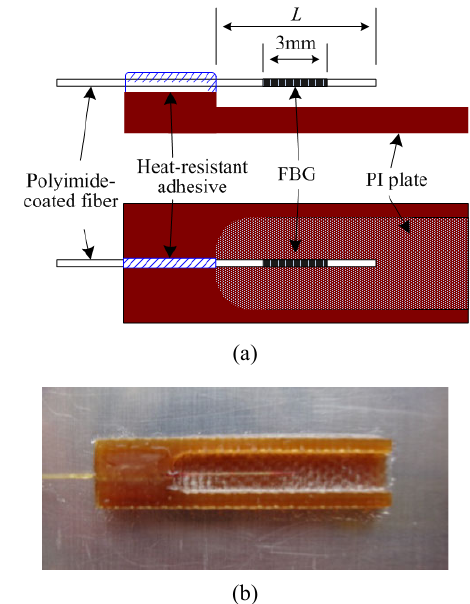
Fig. 2 Structure of the high temperature FBG AE sensor.